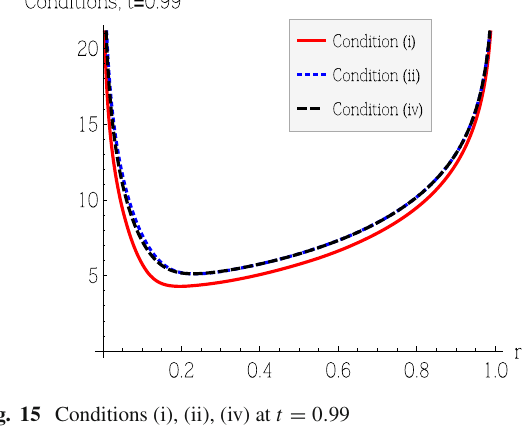
Fig. 18 Conditions (v), (vi), (viii) at t = 0 . 99